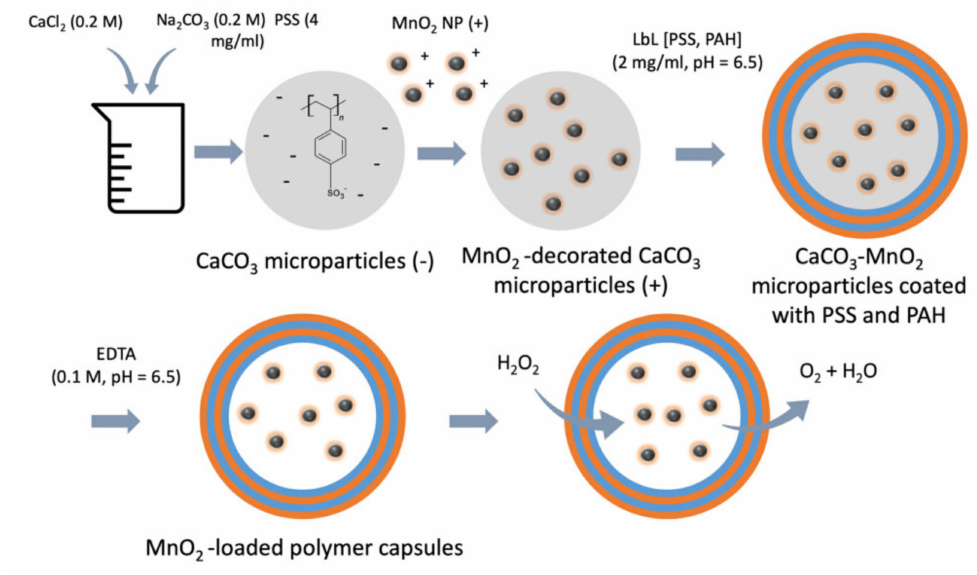
Figure 2. Synthesis and effective diagram of antioxidant microcapsules loaded with manganese dioxide. Reprinted with permission from Marin et al, Mater. Sci. Eng. C Mater. Biol. Appl, published by Elsevier,